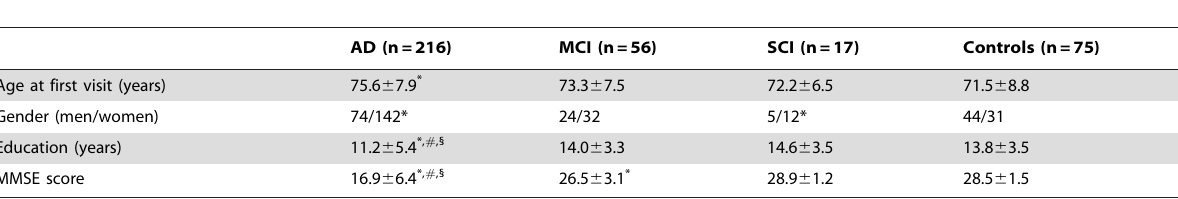
Table 1. Demographic characteristics of the AD, MCI, SCI and control